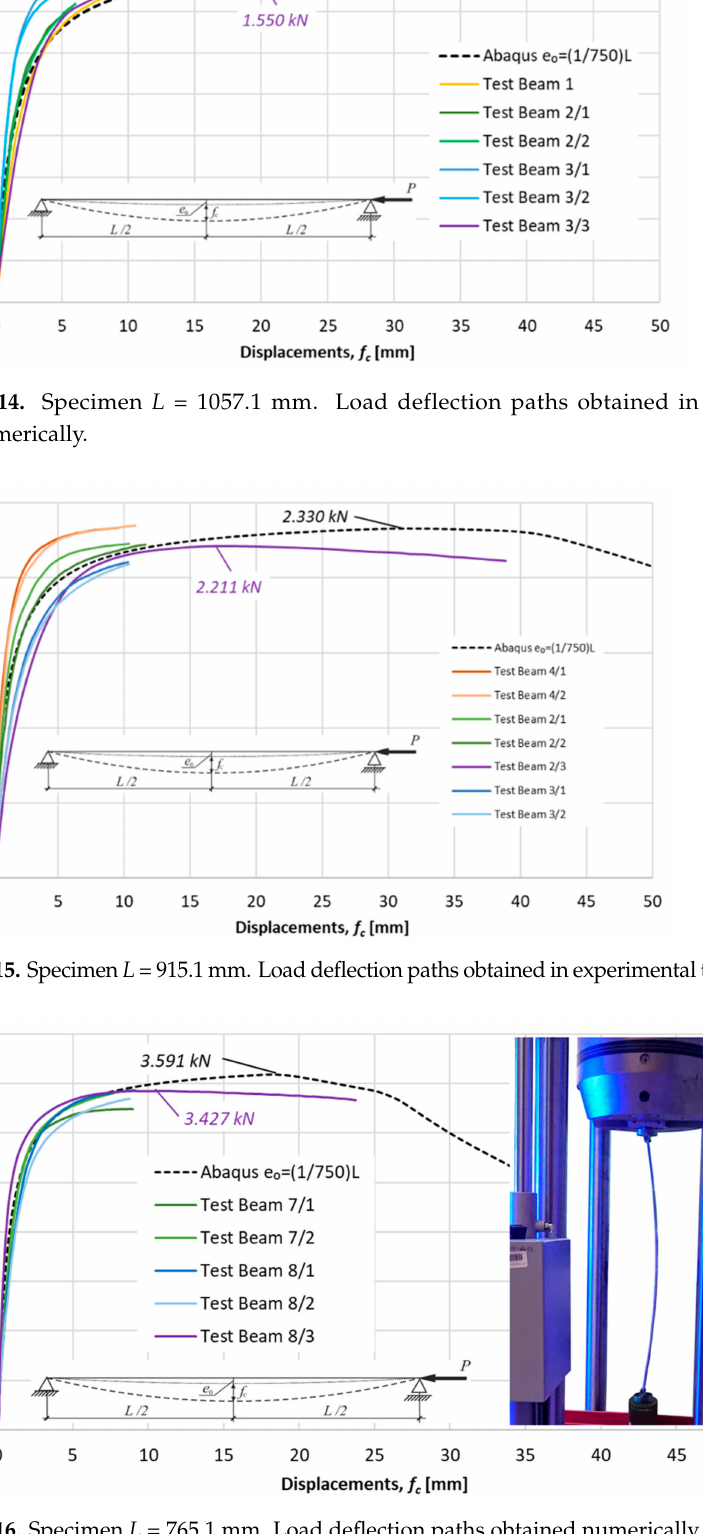
Figure 16. Specimen L = 765.1 mm. Load deflection paths obtained numerically and in experimental tests with the collapse